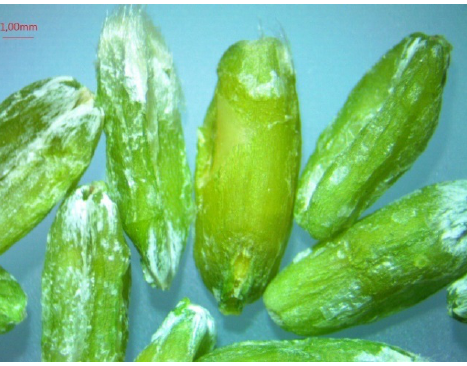
Figure 1. Picture of spelt grain harvested at milk dough stage after freeze-drying (green spelt grain).